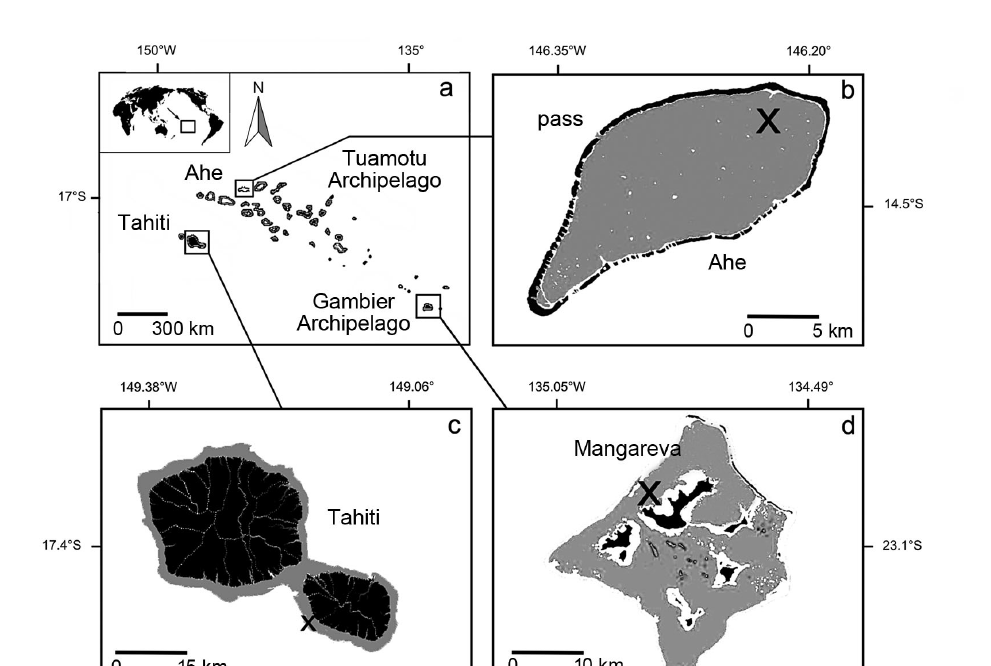
Fig. 1. Location of the 3 islands in French Polyne- sia (a). Crosses show the experimental sites in the lagoons (shaded grey) of Ahe (b), Tahiti (c) and Mangareva